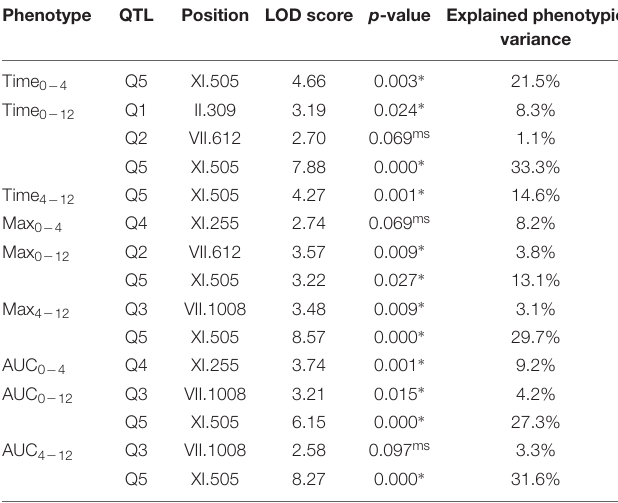
TABLE 1 | Linkage analysis for TORC1 activation.